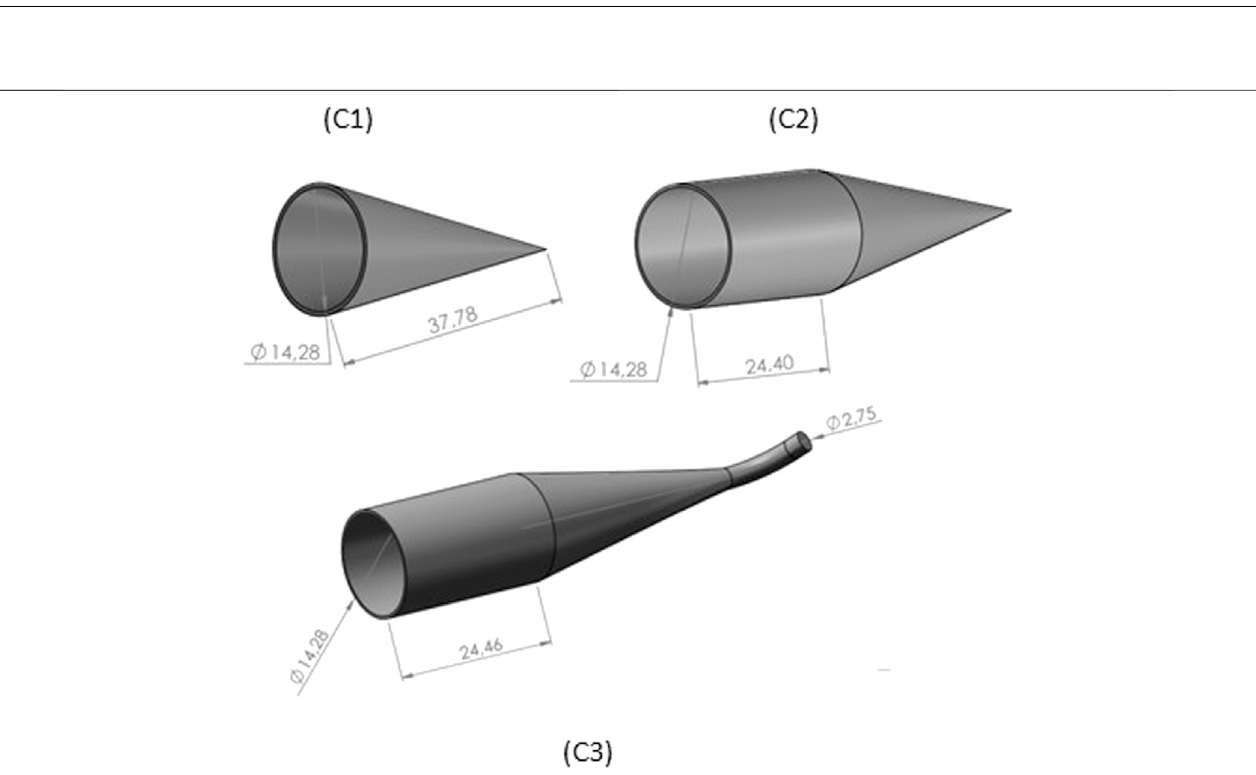
FIGURE 4 | The three geometry shapes of cavity: cone (C1) cylinder/cone (C2) and cylinder/cone with a tube at the apex (C3).